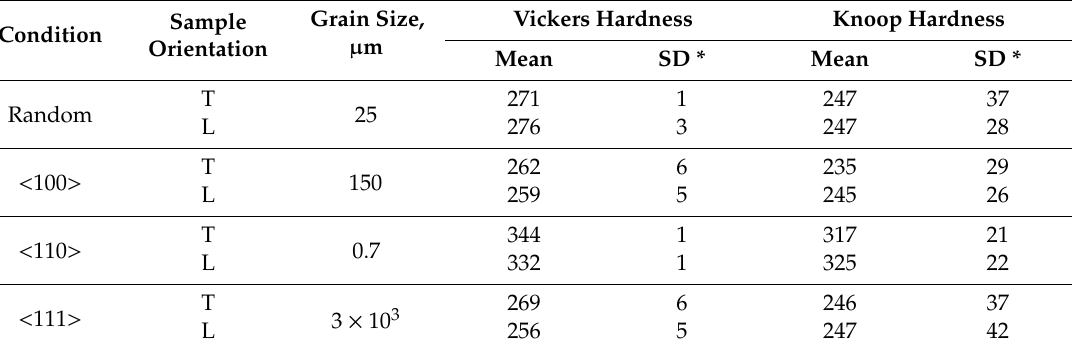
Figure 2. Vickers hardness (10 kgf) numbers of transverse (white columns) and longitudinal (grey columns) cross sections of the four processing conditions. Table 3. Means and standard deviations of Vickers hardness (HV10) and Knoop hardness numbers, on transverse and longitudinal cross sections of Fe20Cr4.5Al alloy in di ff erent